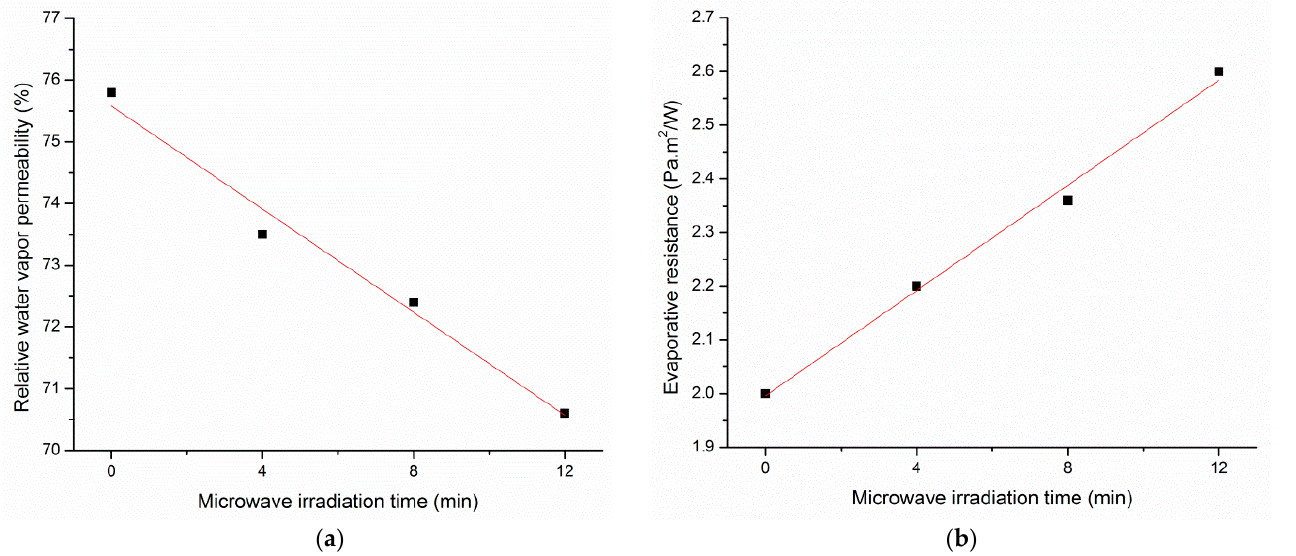
Figure 12. Water vapor permeability of the ZnO-nanorod-coated fabrics at different microwave irradiation times. ( a ): Relative water vapor permeability (RWVP), ( b ): Water vapor resistance (Ret).